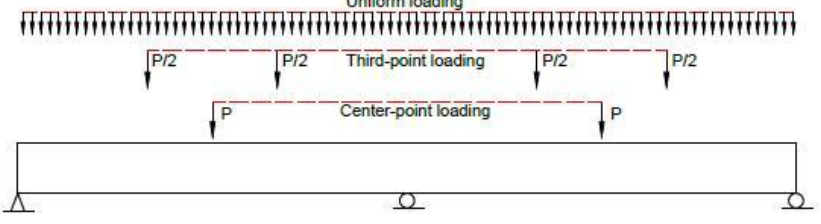
Figure 16. Beams under different types of loading.